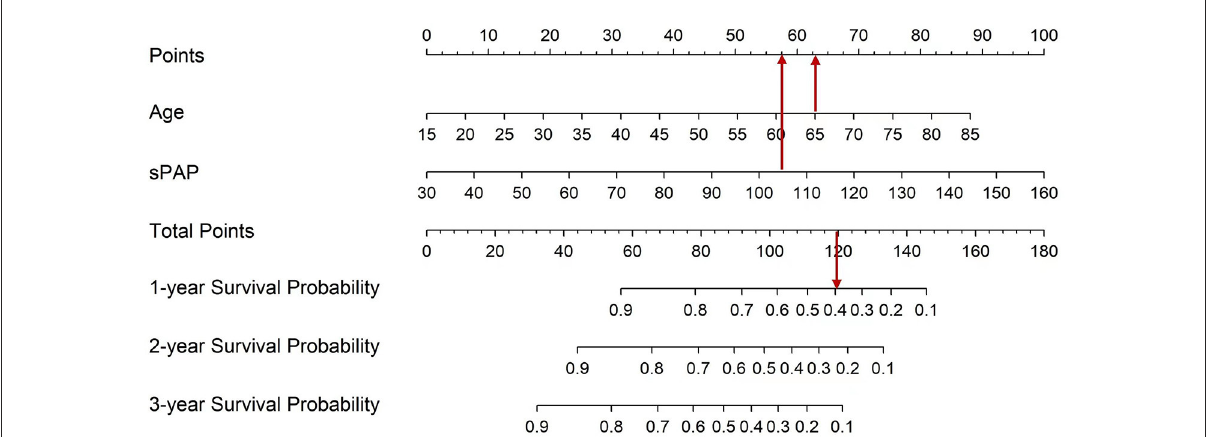
FIGURE5 Nomogram which enabling calculation of predicted probabilities of death for all CKD with PH patients. To use the nomogram, a patient’s values are located on each variable axis, and a line is drawn upward to determine the number of points received for each variable value. The sum of these numbers is located on the total point axis, and a line is drawn downward to the survival axes to determine the probability of survival at 1, 2, and 3 years.